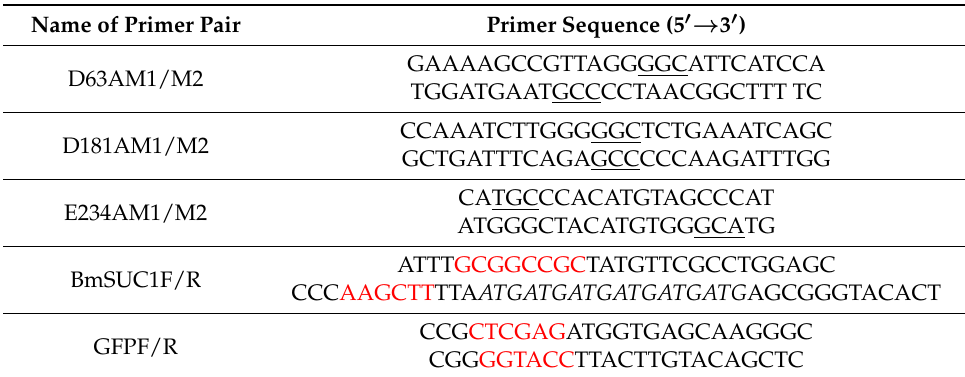
Figure 2. Identification and purification of the enzymes expressed in BmN cells by SDS-PAGE (upper) and western blot (lower) analysis using anti-BmSUC1 antibody. ( A ) wtBmSUC1 expression in the medium and cells (S, supernatant, I, insoluble component); ( B ) Expression of wtBmSUC1 and three mutants in the medium. Blank, cell culture medium after empty vector infection; ( C ) unpurified (U) and purified (P) proteins from the medium. 0.5 μ g of each purified protein was identified by western blot. Table 2. Oligonucleotide primers used in PCR.